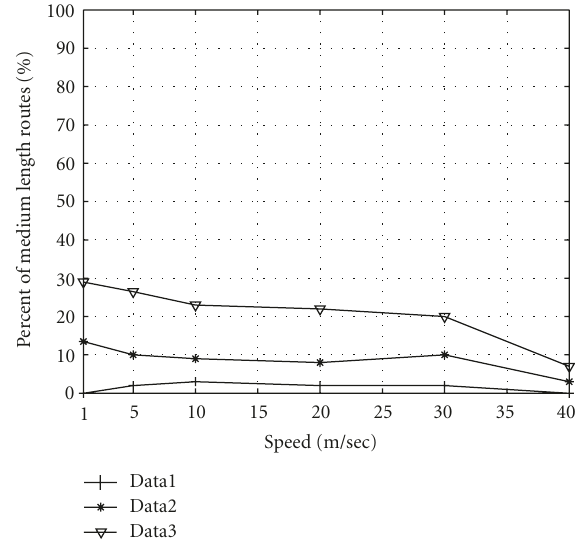
Figure 7: The percent of received TCP packets with medium hop counts (4 ≤ hop count ≤